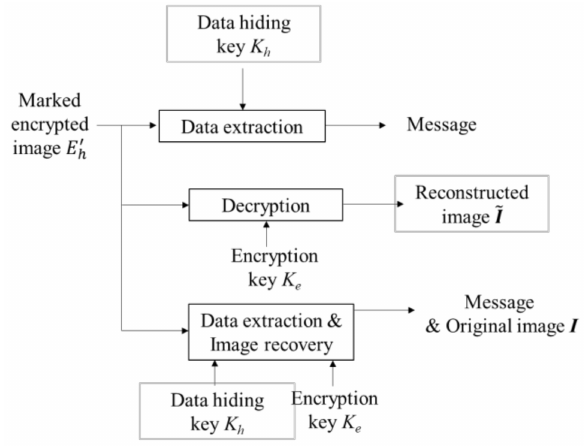
Figure 5. Overview of the decoding